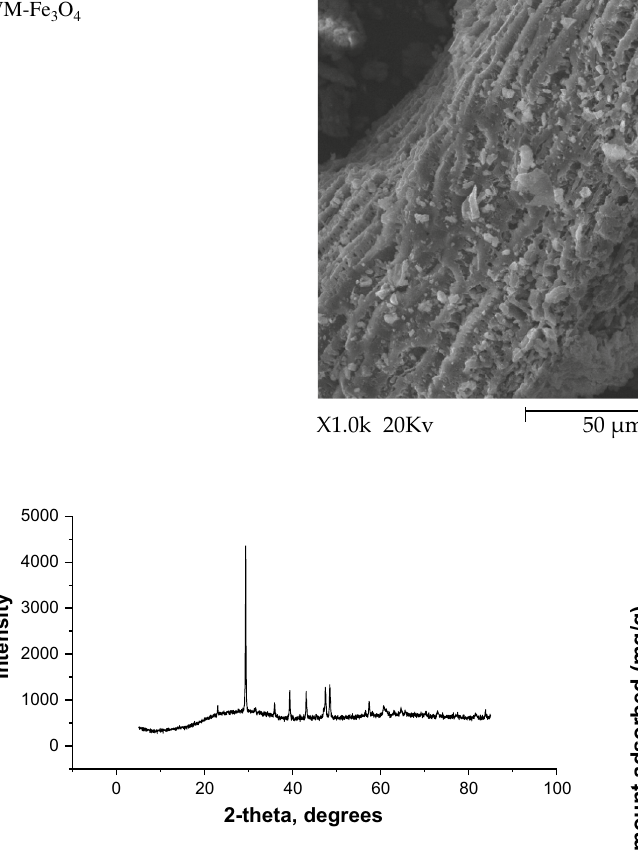
Fig. 2 SEM micrographs of WM-Fe 3 O 4